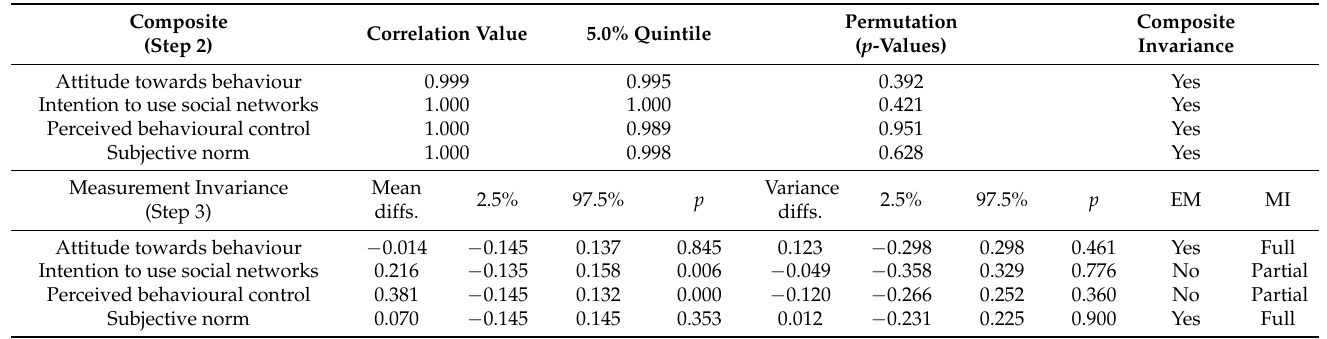
Table 3. Results of the MICOM procedure in elderly adults from Chile .